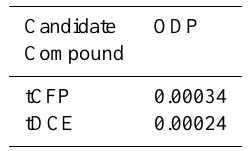
Fig. 2. Annual and zonally- average chlorine perturbations (mixing ratio, ppt) in MOZART 3 resulting from the chloroalkene source gases. (a) All inorganic chlorine (Cl y ) from tCFP. (b) Reactive chlorine (ClO x ) from tCFP. (c) Cl y from tDCE. (d) ClO x from tDCE. Table 3. Ozone Depletion Potentials (ODPs) derived for tCFP and for